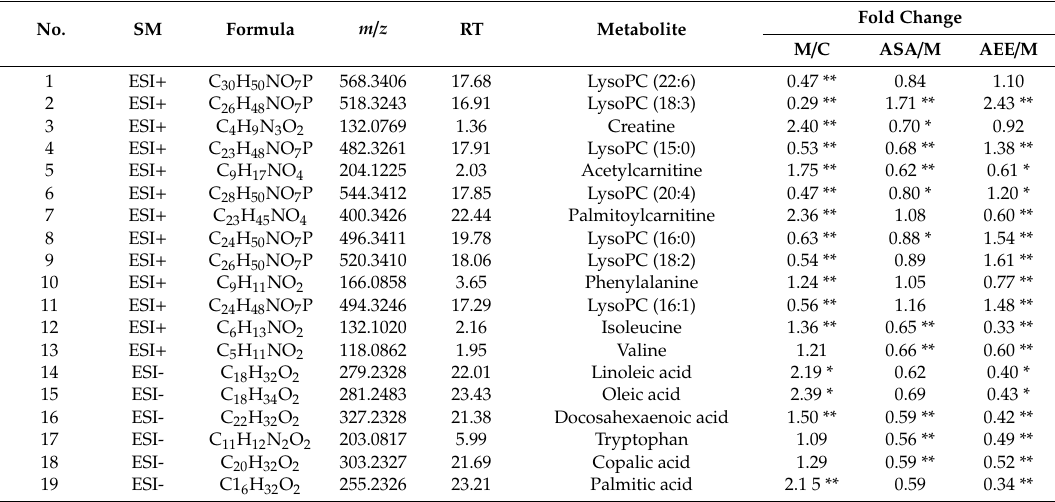
Table 3. Identification results for the candidate metabolites in the plasma of rats with blood stasis.